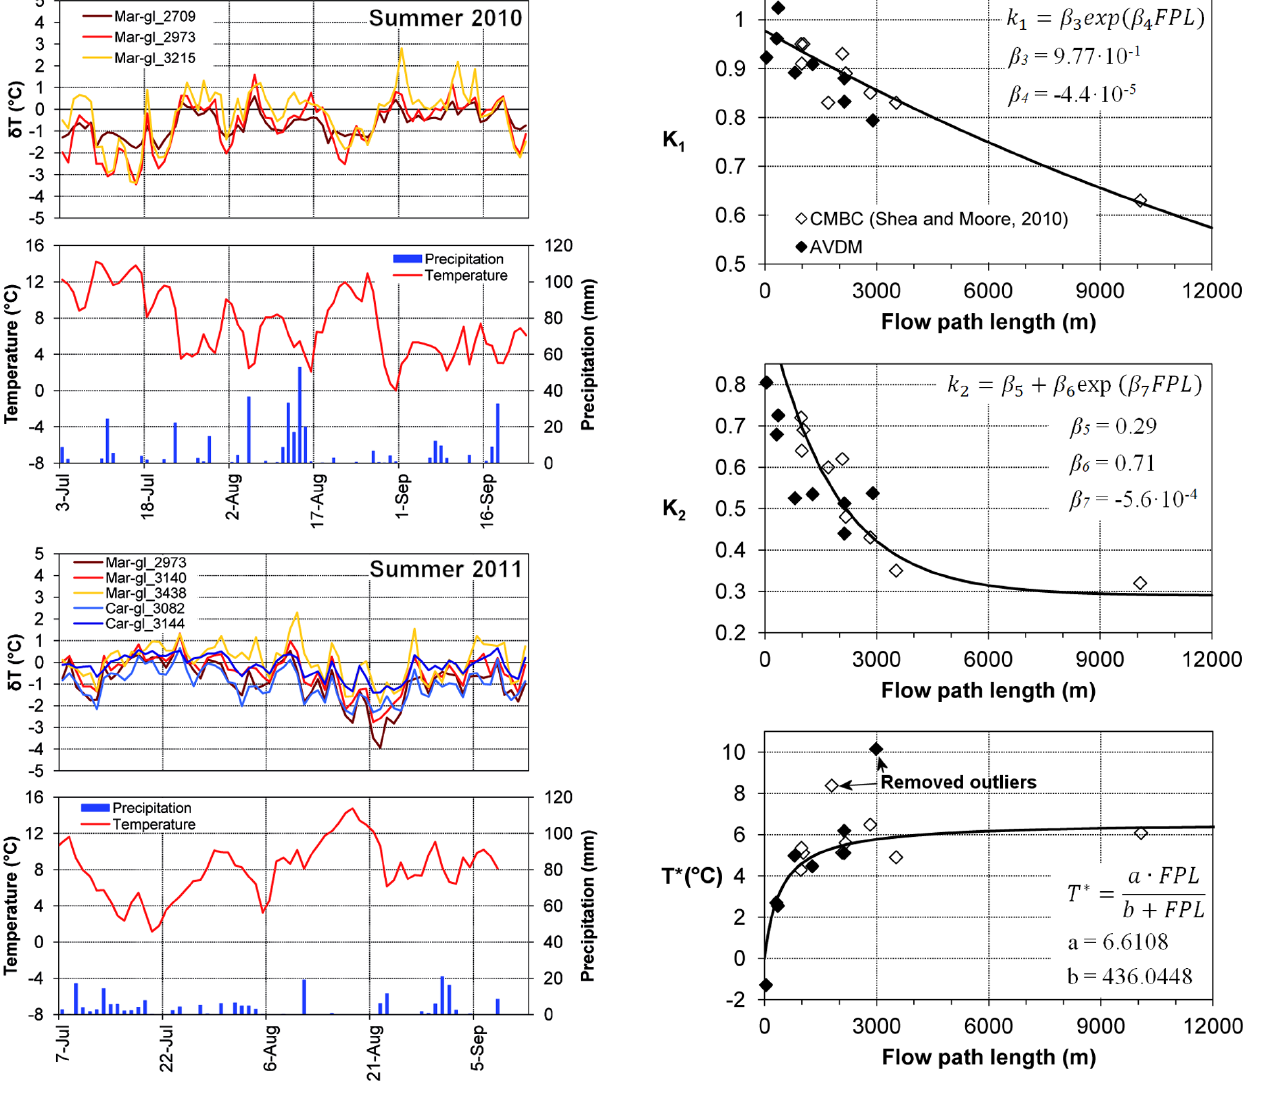
Figure 5. Mean daily cooling effect at the on-glacier weather sta- tions and corresponding daily precipitation and mean temperature at Careser Diga (Car_2607).